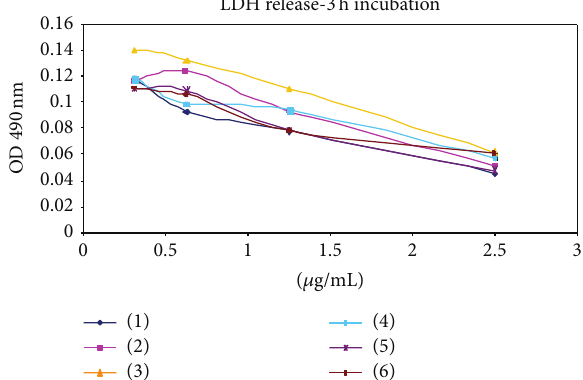
Figure 5: LDH release, on Jurkat cell line, after 3 hours incubation at 37 ∘ C for samples (1)–(6): (1) TMHAPP; (2) THAPP; (3)